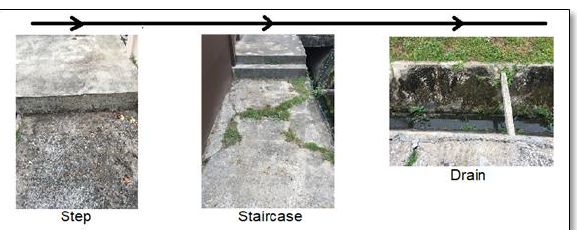
Figure 15. Testing Path 6.